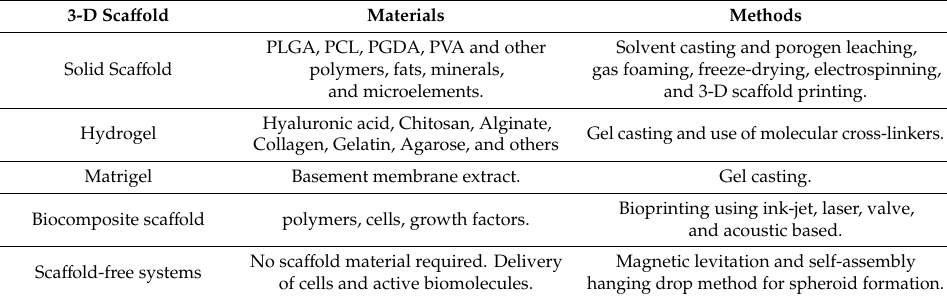
Table 2. Biomimetic 3-D in vitro bone marrow and cancer